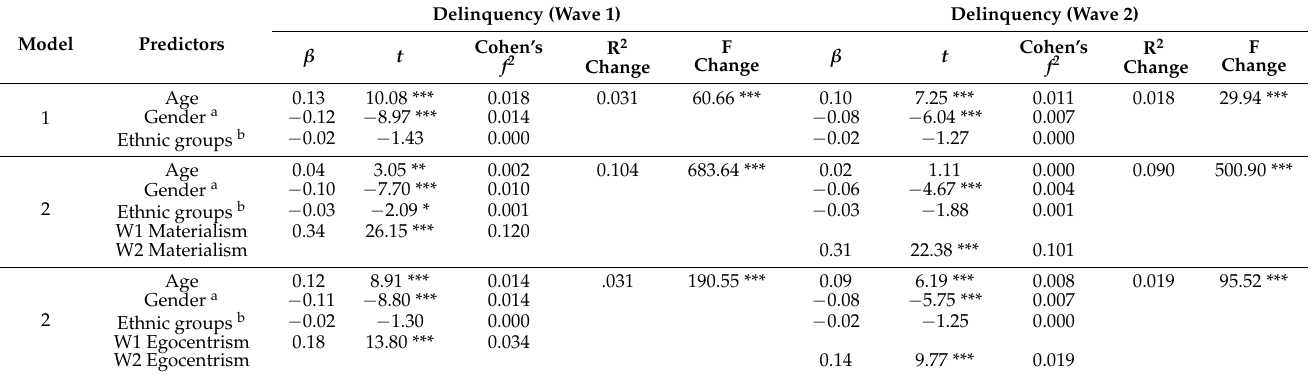
Table 4. Cross-sectional regression analyses for